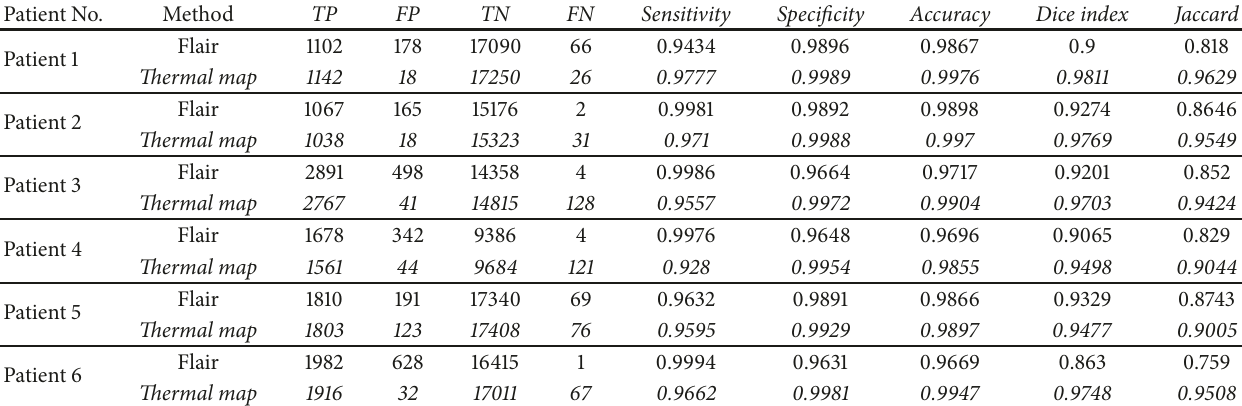
Table 5: The calculated segmentation evaluation metrics for level set method and proposed approach in BRATS Training data 2012. Patient No.